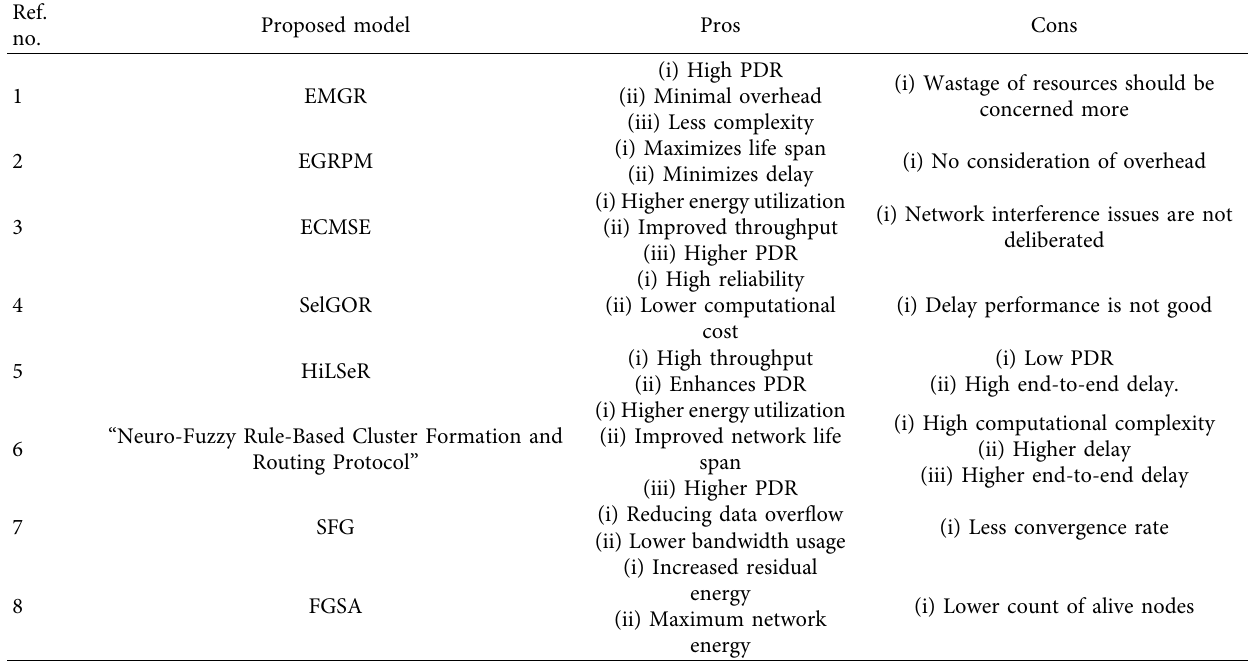
Table 2: Review on conventional routing protocol in WSN.